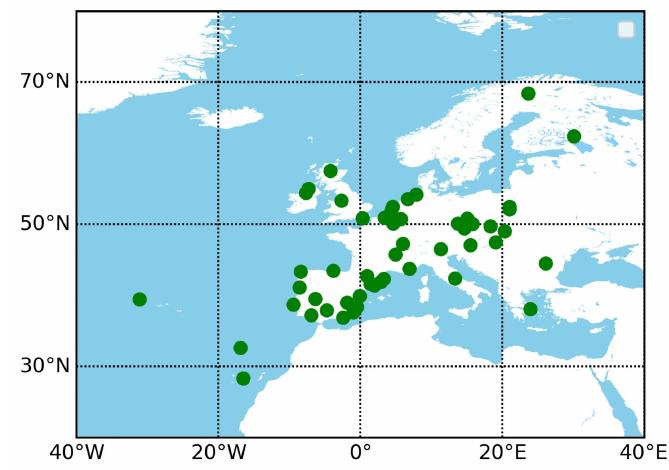
Figure 5. Geographical distribution of the selected EPN (European Permanent Network) stations.